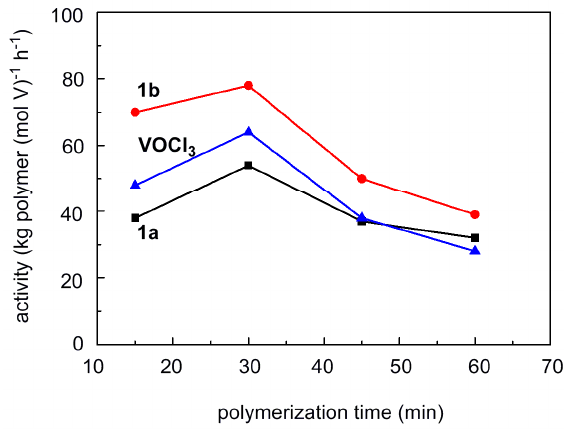
Figure 3. Effect of polymerization time on activity of vanadium-based catalysts in ethylene/propylene polymerization.